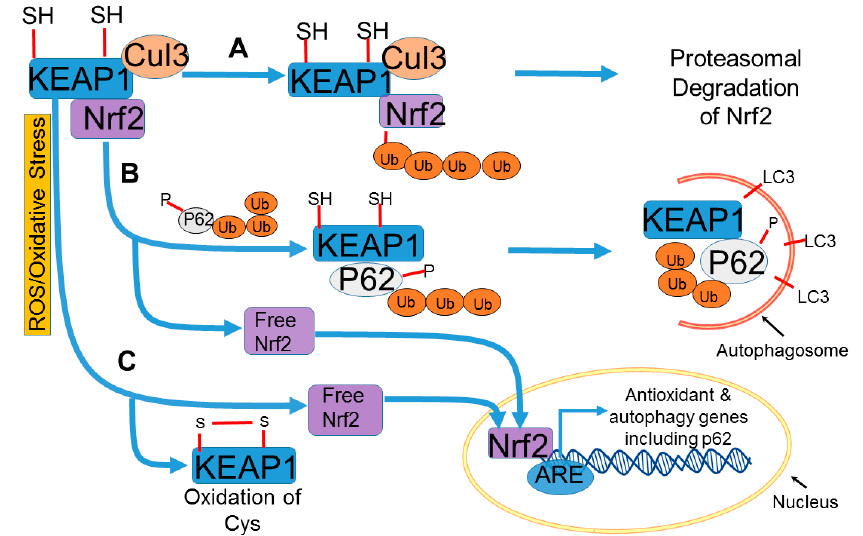
Figure 3. ROS regulation of Keap1/Nrf2/p62 signaling and its impact on autophagy. ( A ) Under normal basal conditions, Keap1 regulates Nrf2 and keeps its level low by ubiquitination and proteosomal degradation. ( B ) P62 has a binding site for Keap 1 and promotes autophagic degradation of Keap1, liberating Nrf2 and enabling Nrf2 to translocate to the nucleus to transactivate target genes to protect against oxidative stress and upregulate autophagy. ( C ) Under oxidative stress conditions, Keap1 is oxidized by ROS-mediated oxidation of cysteine thiols in the cysteine-rich Keap1-Cullin3-based ubiquitin ligase complex, which dissociates Nrf2 from Keap1 and enables Nrf2 to translocate to the nucleus to transactivate target genes, including antioxidant and autophagy genes.